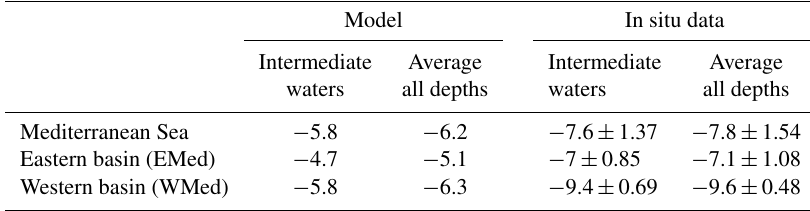
Table 2. Mean ε Nd for the Mediterranean Sea, from EXP3 and for the in situ data from Tachikawa et al. (2004).